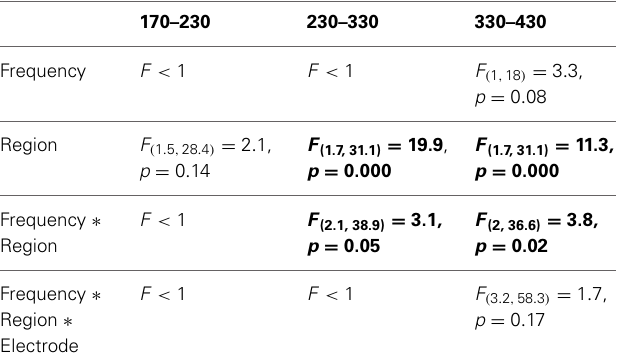
temporal window.